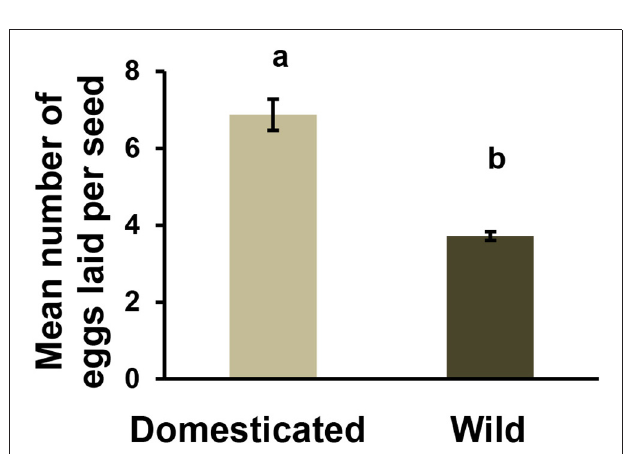
FIGURE 3 | Mean number of eggs laid per domesticated and wild seed in a no-choice experiment. [ N = 121, F (1.233) = 13.32; p < 0.001]. Different letters indicate a significant difference. Bars are means ± SE.